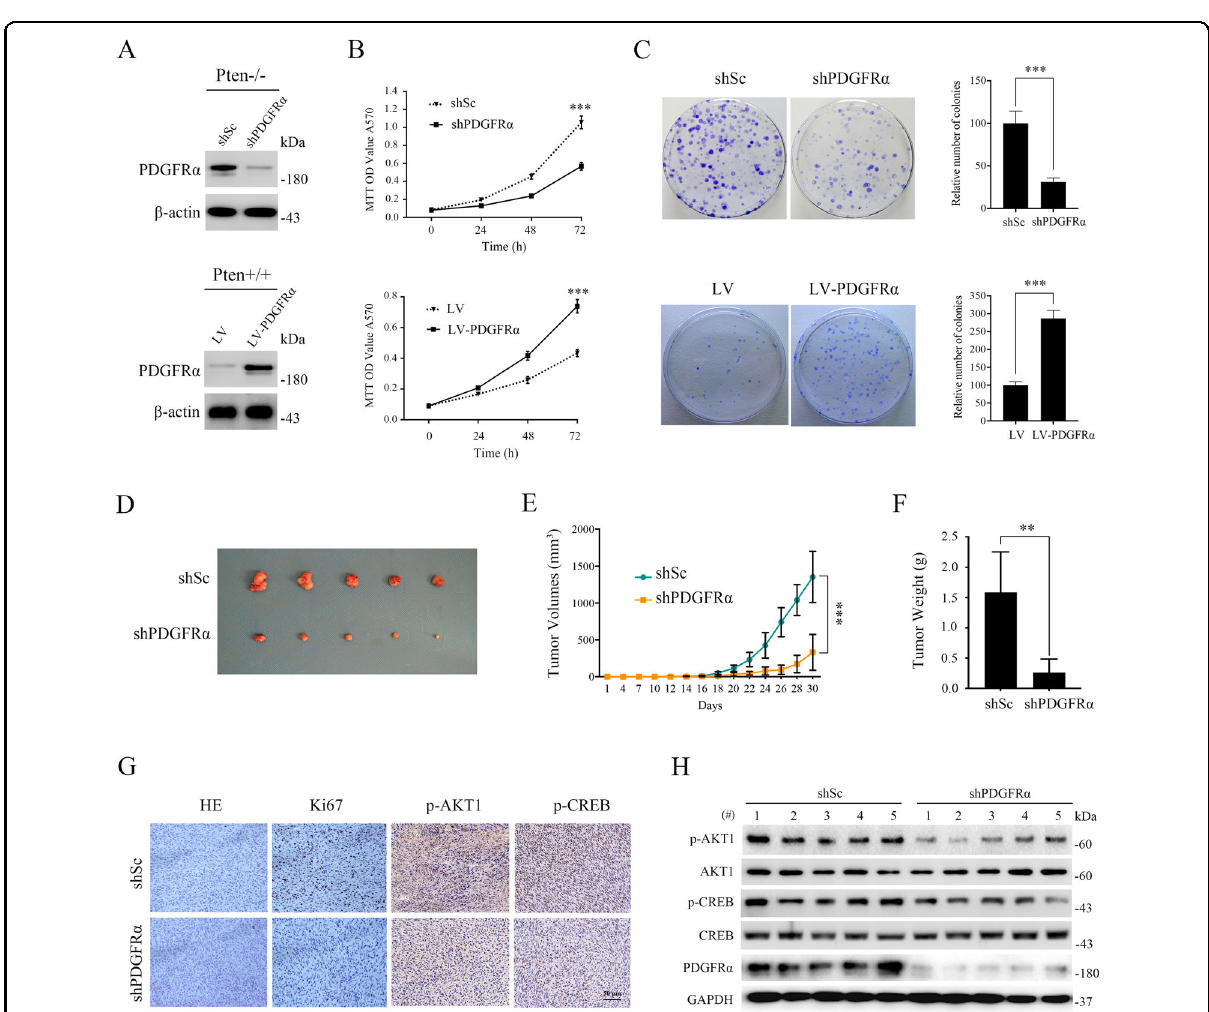
Fig. 4 PDGFR α promotes the proliferation of Pten-de fi cient cells in vitro and in vivo. A Pten − / − MEFs were stably expressing shRNAs targeting PDGFR α (shPDGFR α ) or a control shRNA (shSc) (upper panel). Pten + / + MEFs infected with lentivirus harboring a vector encoding PDGFR α (LV- PDGFR α ) or the empty vector (LV) (lower panel). Cell lysates were subjected to immunoblotting with the indicated antibodies. B Proliferation of the indicated cells was examined using MTT assay. C Colonies formed by the indicated cells were stained and counted. Representative images (left panels) and quanti fi cations (right panels). D – H Pten − / − MEFs infected with shPDGFR α or shSc lentiviruses were inoculated subcutaneously into nude mice, following by monitoring for tumor growth. Tumor pictures ( D ). Tumor volumes at different times ( E ). Tumor weight ( F ). Tumor tissues were embedded with paraf fi n and then subjected to H&E and immunohistochemistry analysis (200×). Representative images were presented ( G ). Tumor tissue lysates were subjected to immunoblotting with the indicated antibodies. H Error bars indicate mean ± SD of triplicate samples. ** P < 0.01; *** P <